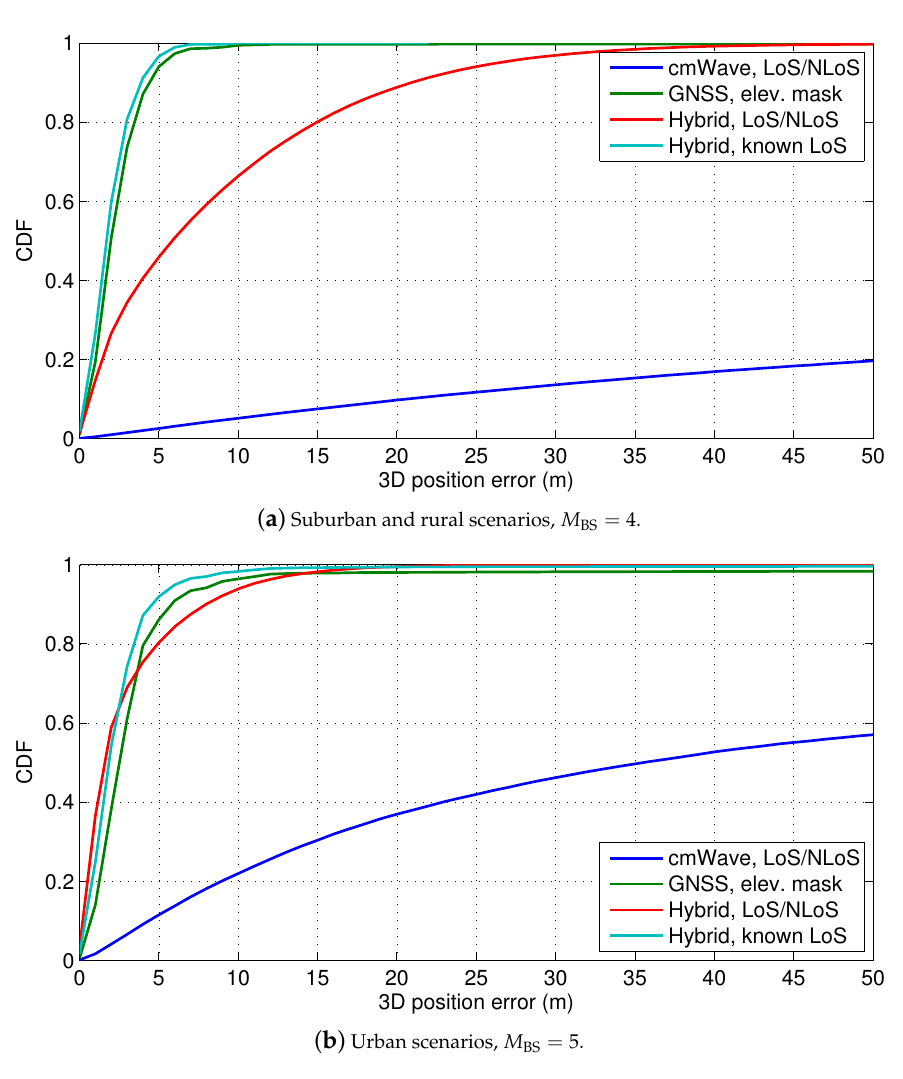
Figure 11. CDF of the 3D position error with hybrid GNSS and cmWave positioning in urban, suburban and rural